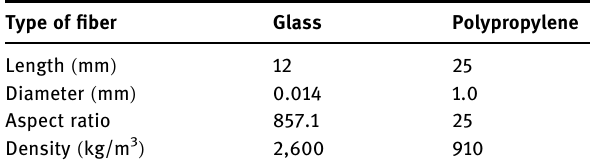
Table 6: Technical data of SikaFume - HR Property